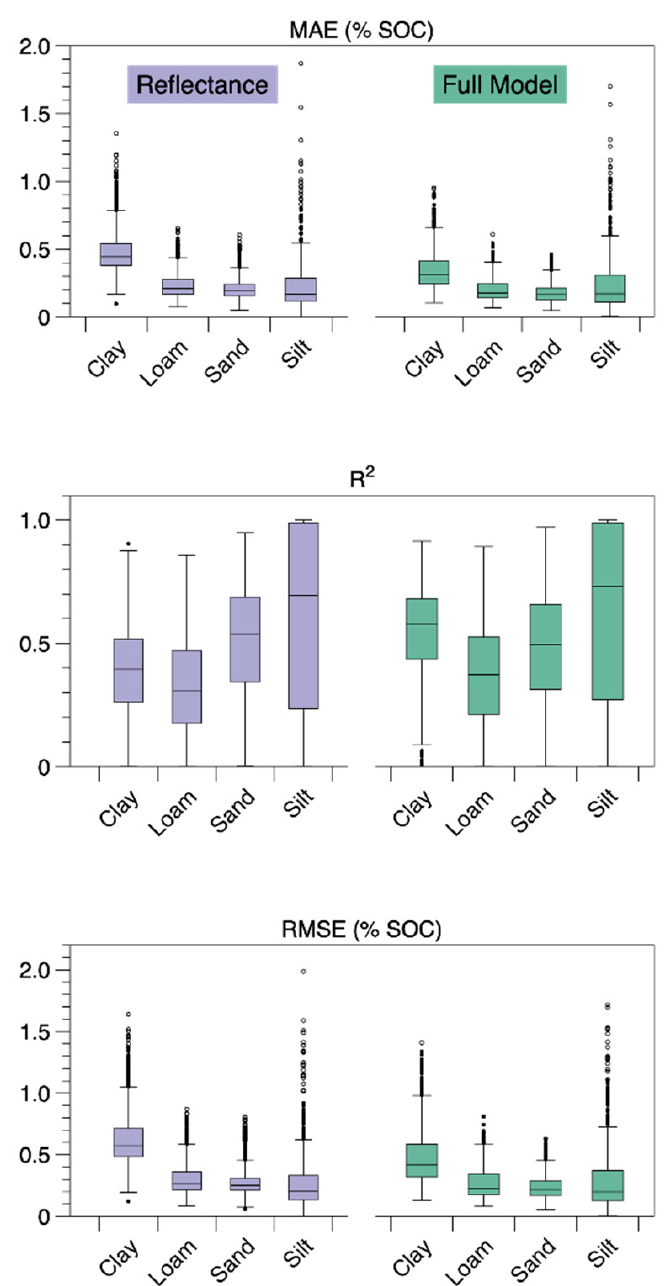
Figure 6. Model performance measured as Mean Absolute Error (MAE), coefficient of determination (R 2 ), and Root Mean Square Error (c) across USDA soil textures ( n = 1738). Model bars in each boxplot represent the median value of 100 train/test splits for the corresponding model; outer edges of the boxes represent the 25 and 75% percentiles; whiskers represent 1.5 × the interquartile range, and points represent outlying values greater than 1.5 × the interquartile range from soils collected from nineteen participating ranches encompassing approximately 17,347 ha in the Southern Great Plains ecoregion of the United States.